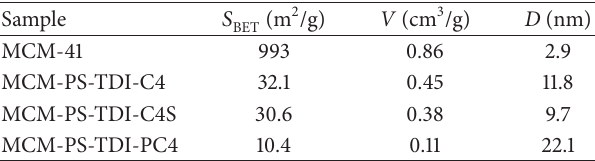
Table 4: Structural parameters of MCM-41, MCM-PS-TDI-C4,